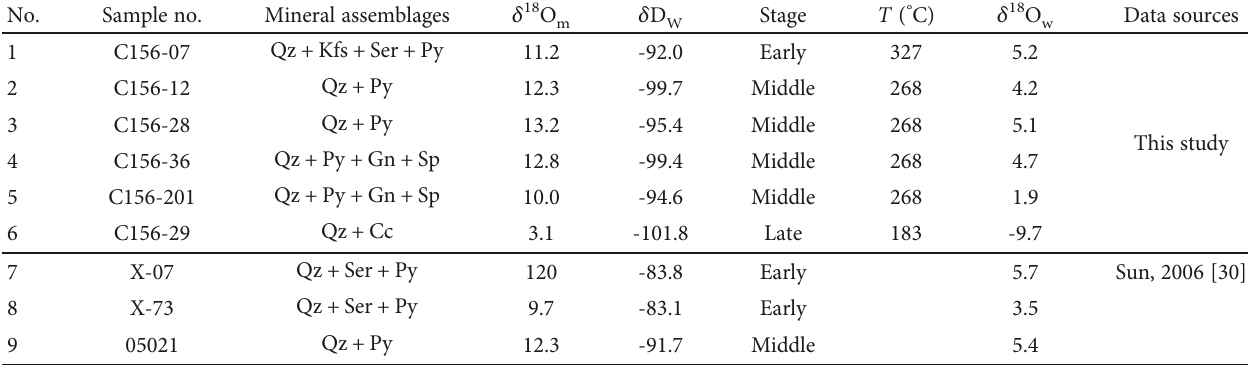
, δ 18 O , and δ D ratios ( ‰ ) for quartz from the Xiejiagou gold m w